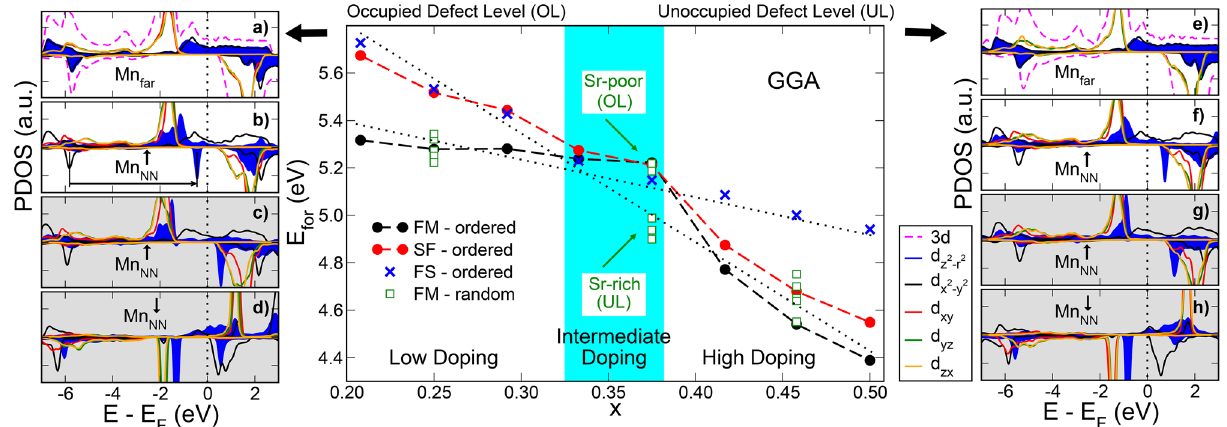
Figure 4. Left/Right Panel: PDOS on the Mn d orbitals for the low/high doping concentration. Mn far stands for a Mn atom located far away from the defect and Mn NN an atom nearest neighbour to the vacancy (see Fig. 2). The two topmost PDOS graphs are for the FM state while the two grey-shaded bottom graphs are for the spin-flip (SF) state. Dashed magenta line is the Mn 3d PDOS in bulk pristine LSMO. Central Panel: Formation energy for an isolated oxygen vacancy as a function of Sr doping (x), for the ordered and the random dopant distributions. For the ordered case, both FM and SF calculations are shown with dashed lines and the fix-spin (FS) case, with